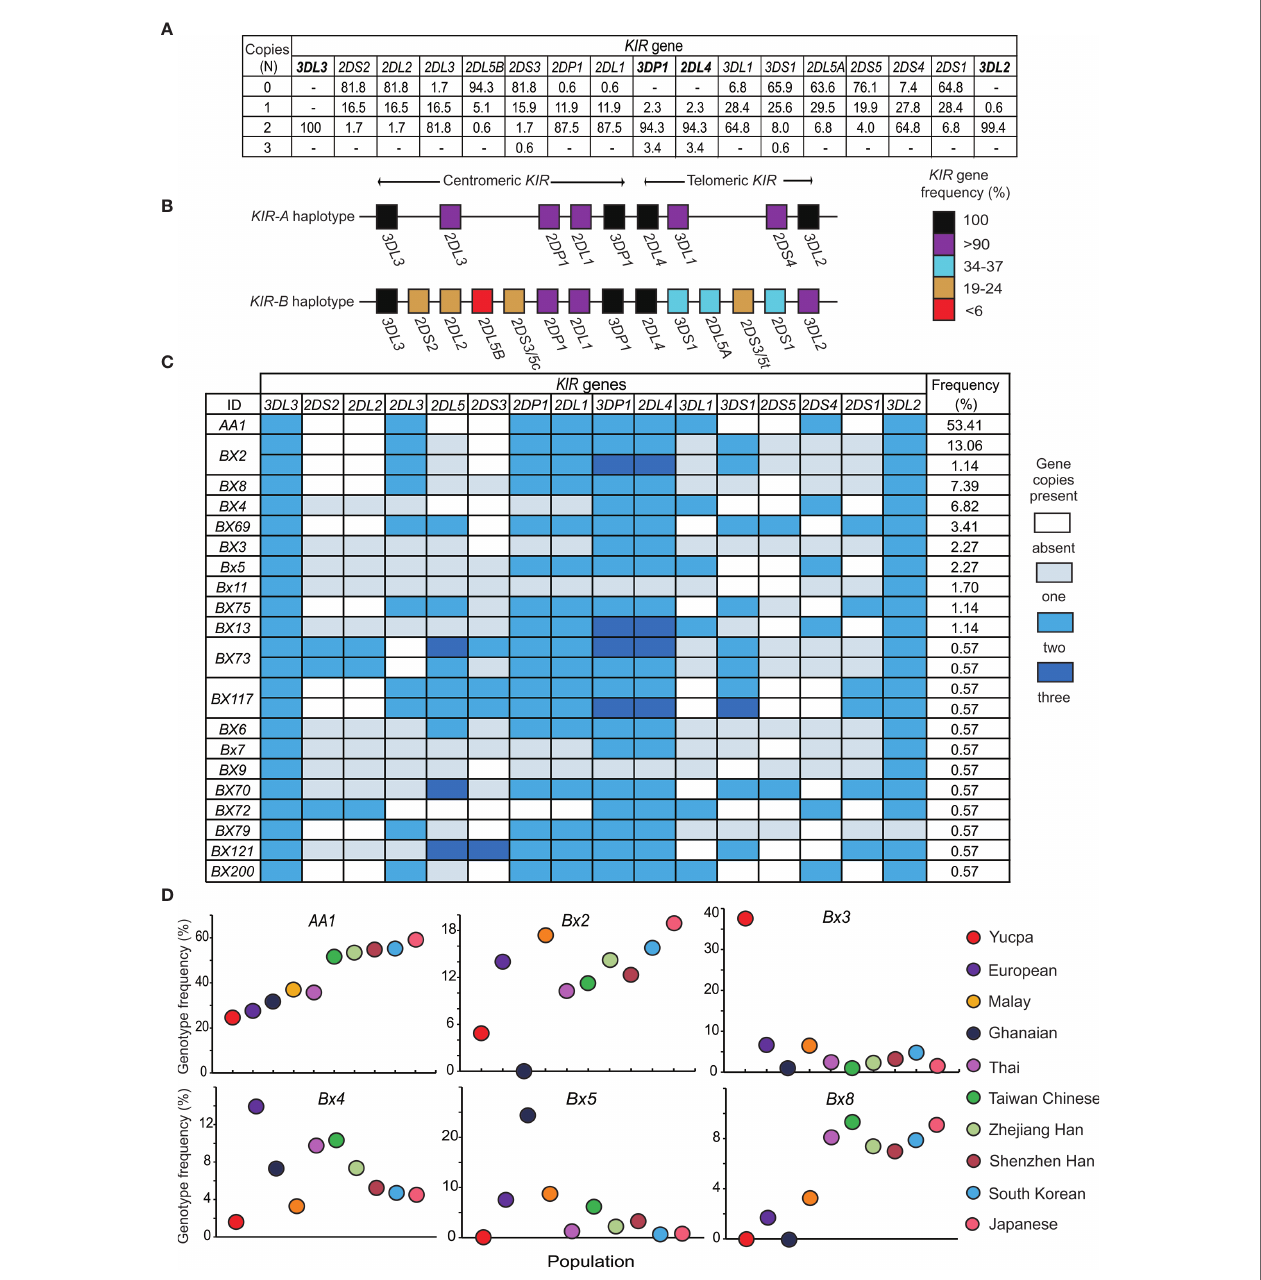
FIGURE 1 | Distribution of genotypes derived from 176 Zhejiang Han individuals. (A) Shown for each KIR gene is the frequency (%) of individuals carrying the number of copies indicated at the left (0 – 3). Dash “–” represents not observed. The four framework genes are indicated in bold text. (B) Shown is the percentage of KIR-A and KIR-B haplotypes that carry each of the genes indicated. Shades of red to black represent the percentages, and the key is shown at the right. (C) Shown are KIR gene content genotypes observed in the Zhejiang Han individuals. The colors of the boxes indicate the gene copy numbers, as given in the key at the right. Genotype IDs based on the presence or absence of KIR genes (39) are shown on the left. The frequencies (%) of the corresponding genotypes are listed in the right. (D) Shown are the carrier frequencies of KIR gene content genotypes -AA1 , Bx2 , Bx3 , Bx4 , Bx5 , Bx8 in ten different populations. They are Chinese Southern Han from Shenzhen (36), Japanese (37), South Korean (43), Taiwan Chinese (44), Malay (45), Thai (46), Europeans (47, 48), Sub-Saharan Africans Ghanaians (49) and South American Yucpa (50). The colored circles represent the populations, as shown at the